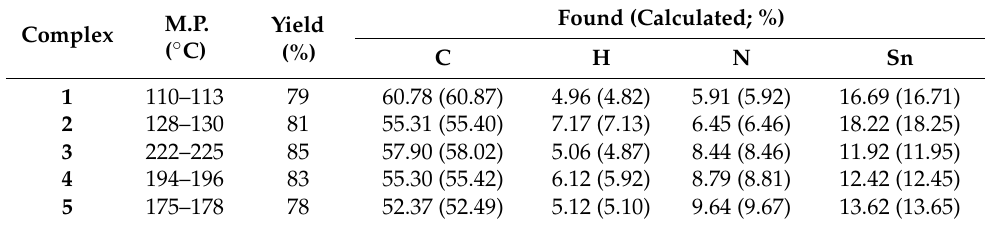
Table 1. Melting point, yield, and microanalyses of complexes 1–5